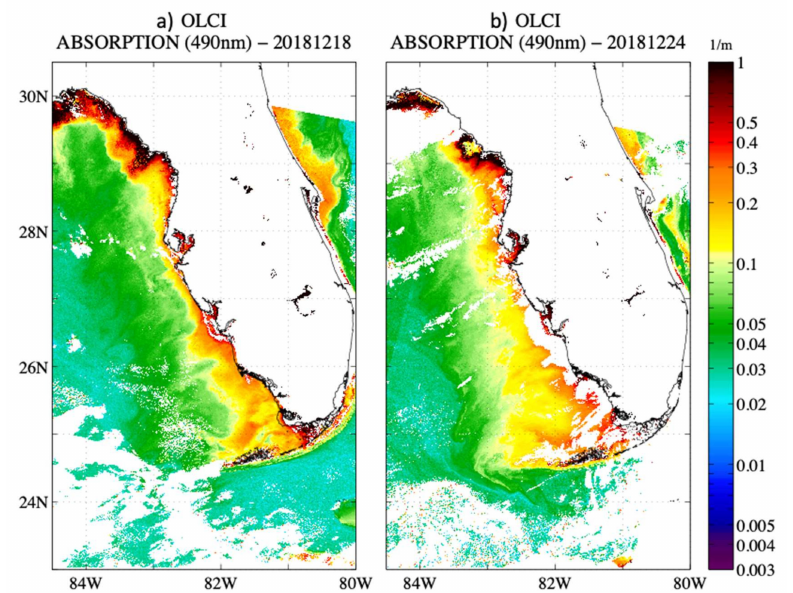
Figure 16. ( a ) The QAA absorption coefficient 490 nm band OLCI, Sentinel 3A, 18 December 2018 and ( b ) the QAA absorption coefficient 490 band OLCI, Sentinel 3B, 24 December